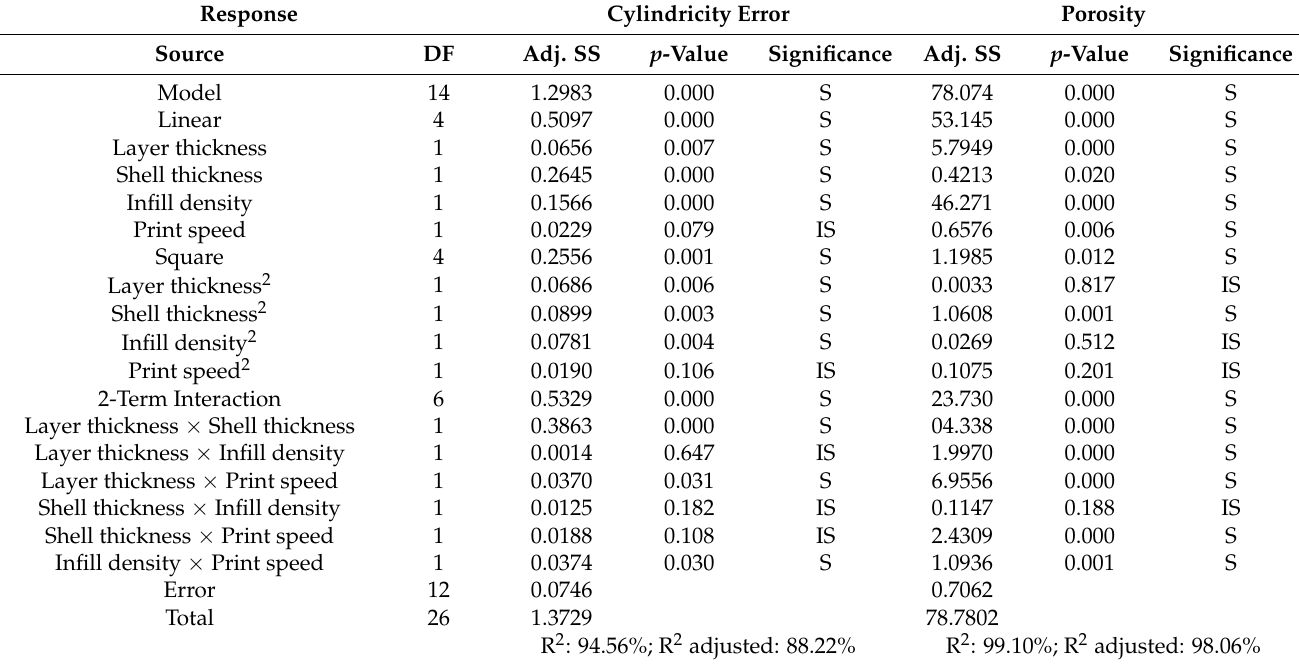
Table 4. Analysis of variance for cylindricity error &